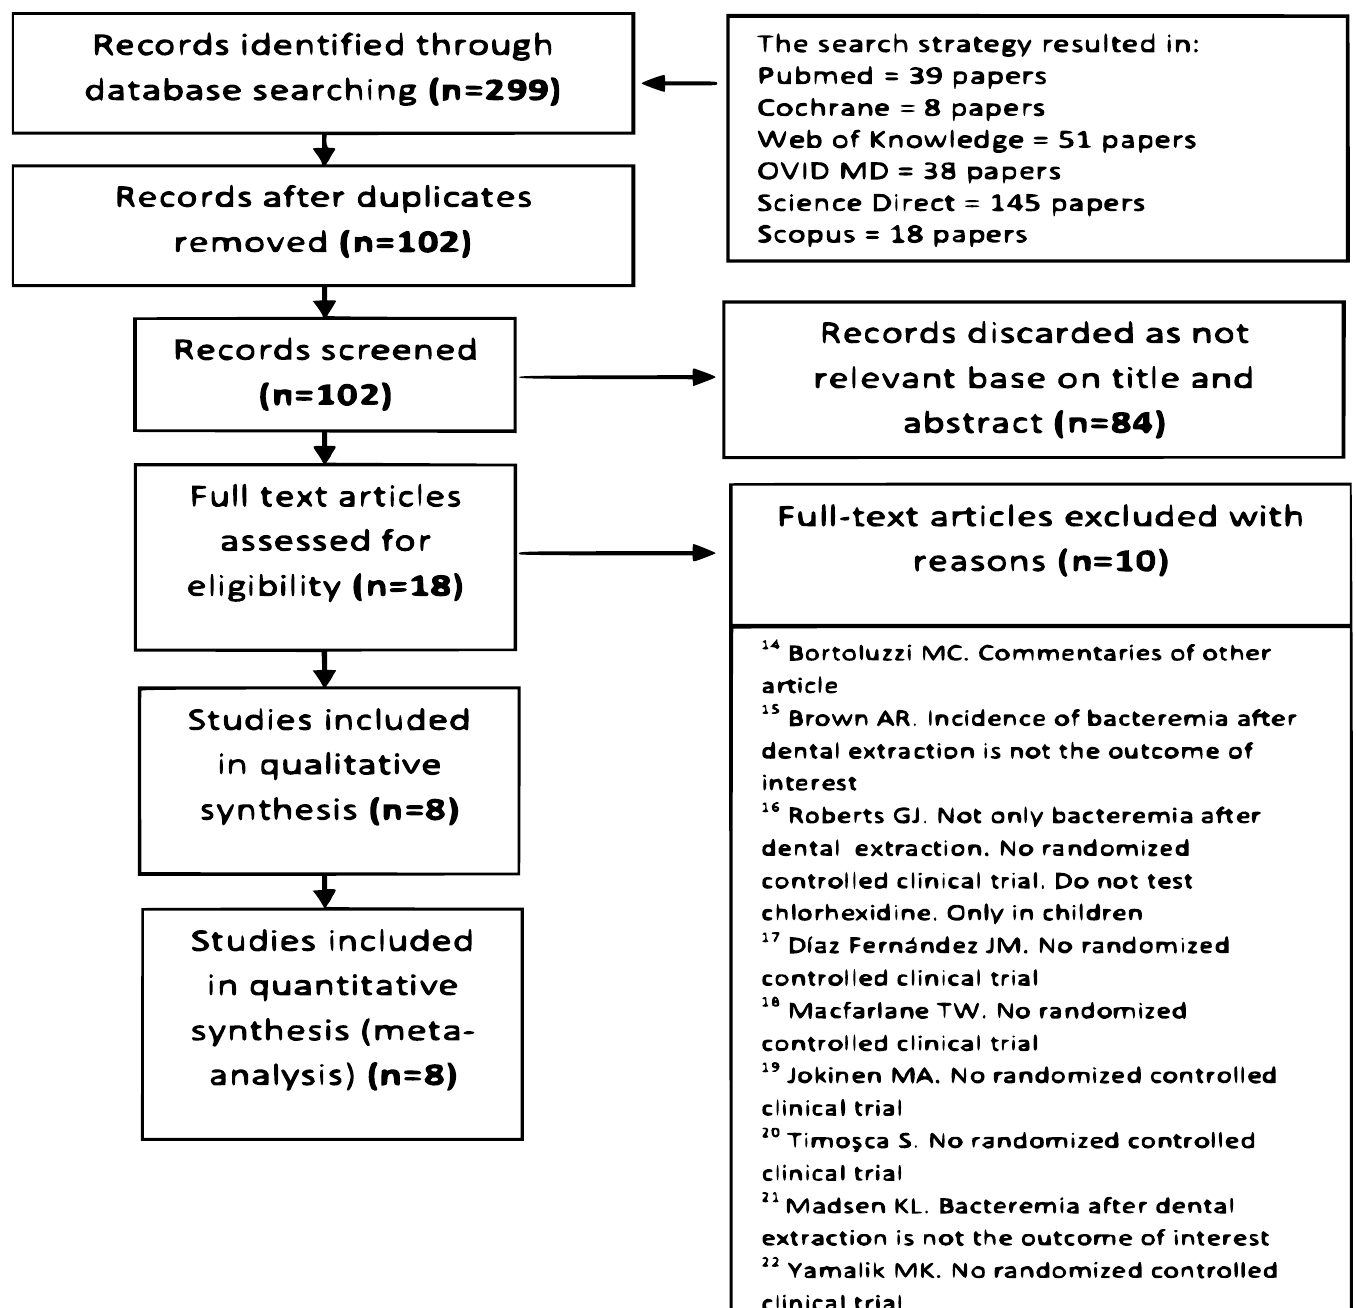
Fig 1. PRISMA flow diagram. Flow diagram showing the study identification, screening and inclusion process.